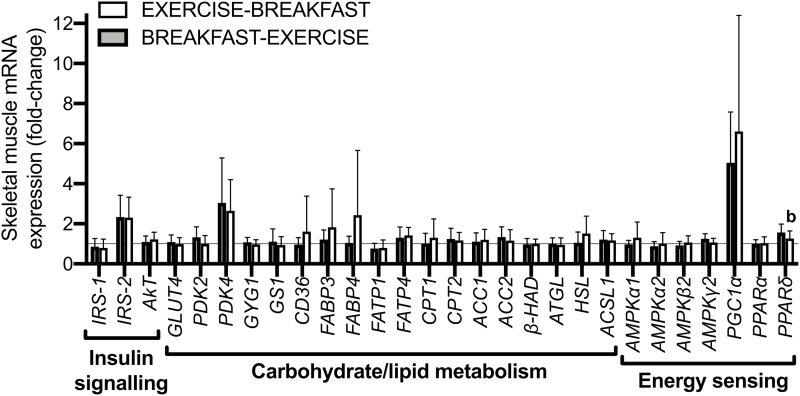
Skeletal muscle mRNA expression responses to a single bout of exercise before versus after nutrient provision (in the form of breakfast) in overweight men (n = 8). Muscle was sample pre-exercise and at 3 hours postexercise (vastus lateralis) to assess the intramuscular gene expression responses to exercise. The difference between EXERCISE-BREAKFAST vs BREAKFAST-EXERCISE. (P < 0.05).